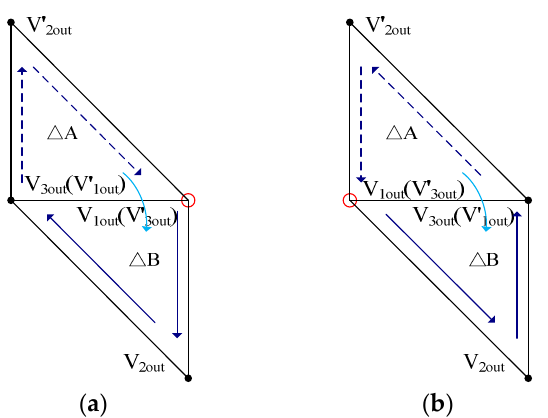
Figure 10. Switching paths in the second kind of quadrangle, ( a ) state 1; ( b ) state 2.